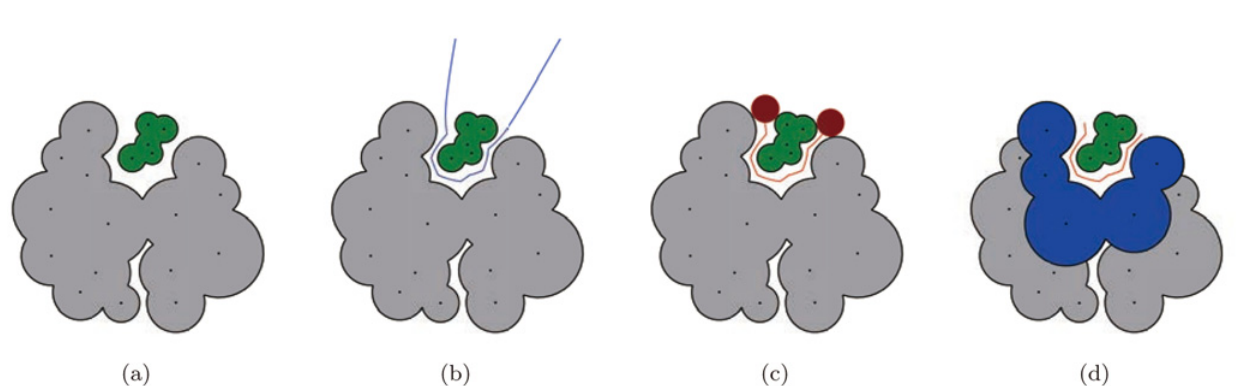
Fig 5. The interaction interface (IIF) of a two-dimensional molecule complex and the optimal pocket defined by IIF . The gray and green objects are a receptor molecule M R and a ligand molecule M L , respectively. (a) A two-dimensional molecule complex, (b) IIF 1 shown as the blue curve, (c) IIF shown as the red curve trimmed by the red circle, and (d) the optimal pocket consisting of the five blue atoms and IIF .